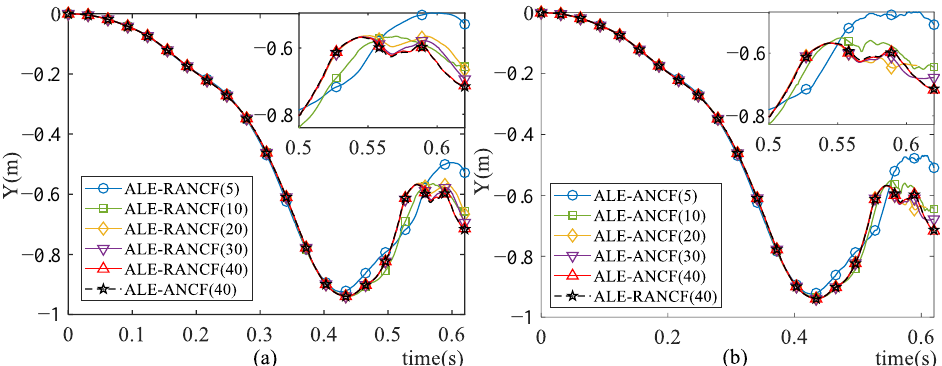
Figure 10. Y-axis displacement of right end node of beam in ( a ) ALE-RANCF and ( b ) ALE- ANCF